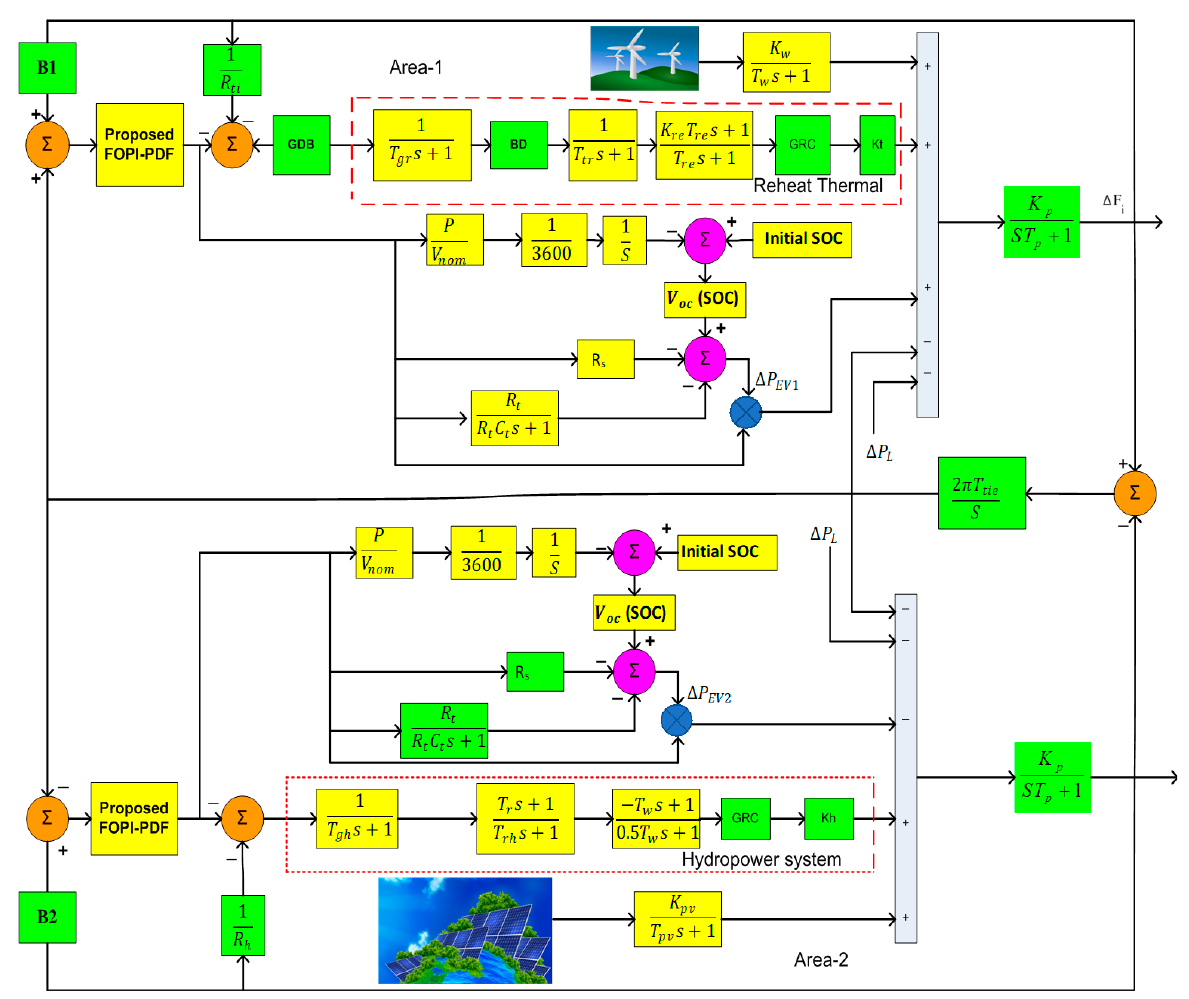
Figure 1. Transfer function model of hybrid power system.